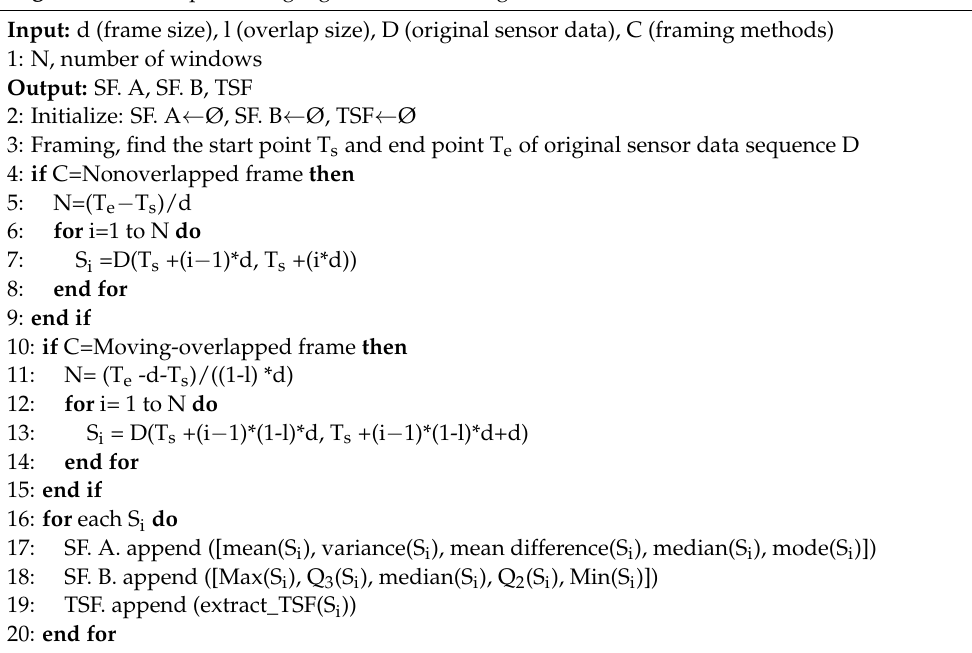
Algorithm 2 Data processing algorithm of framing